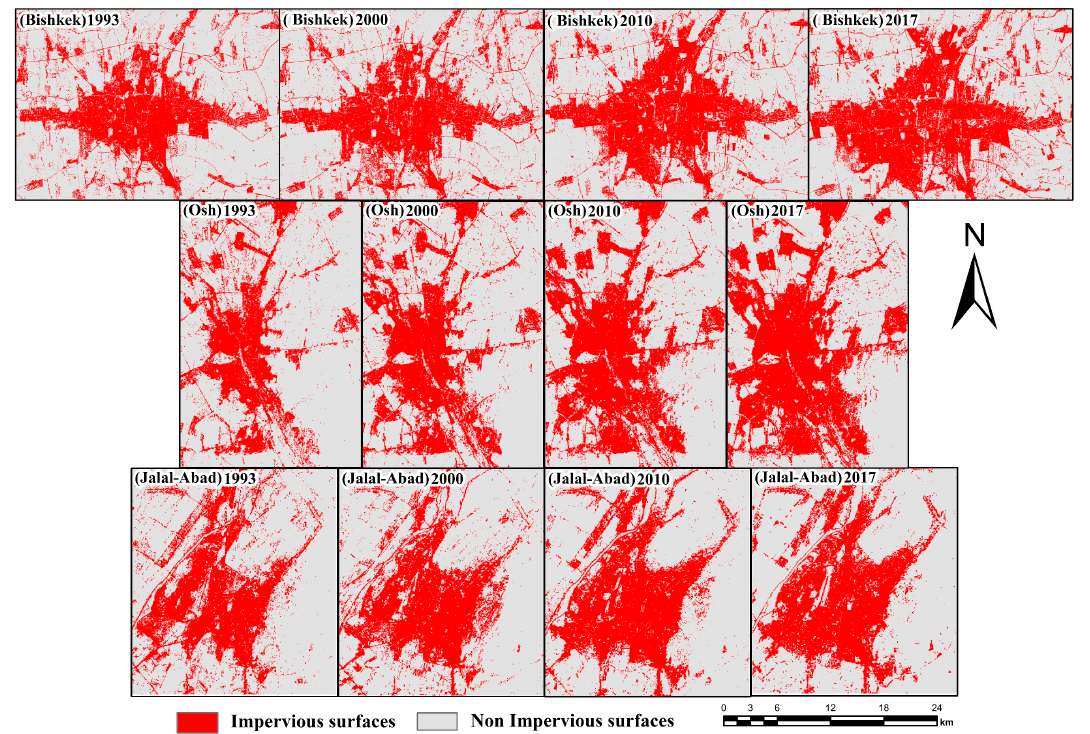
Figure 6. Map of impervious and nonimpervious surfaces for the three main cities.